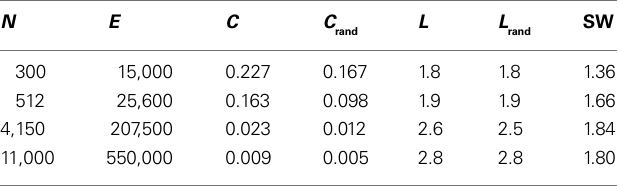
Table 2 | Graph and small-world characteristics of hierarchical networks with constant node